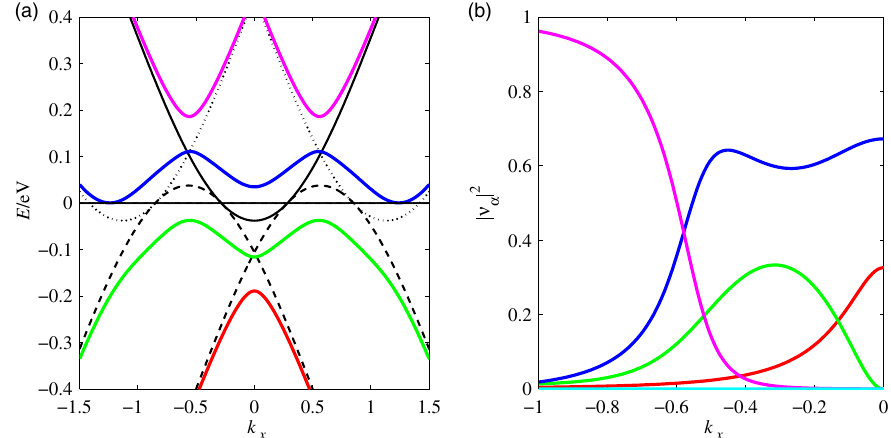
− μ Þ . The (cid:2) Q